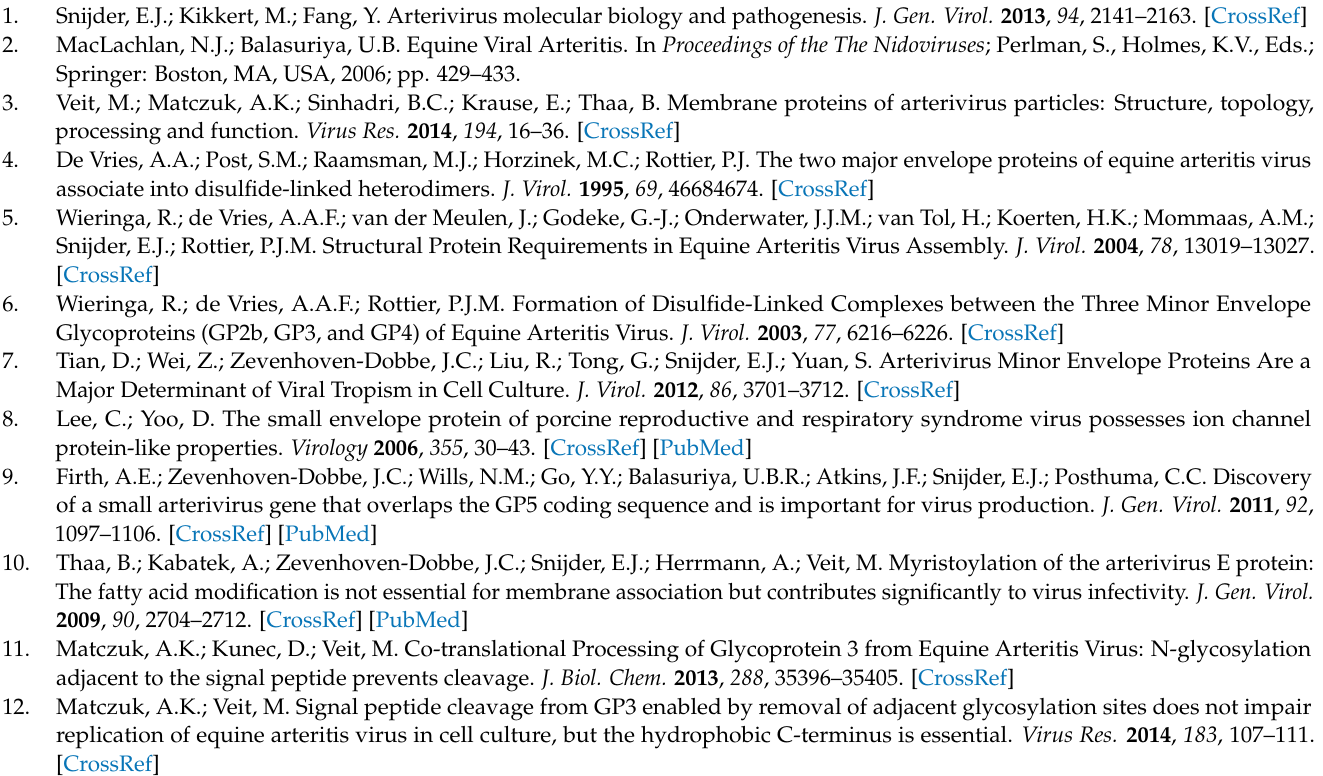
Table S1: List of primers used in the